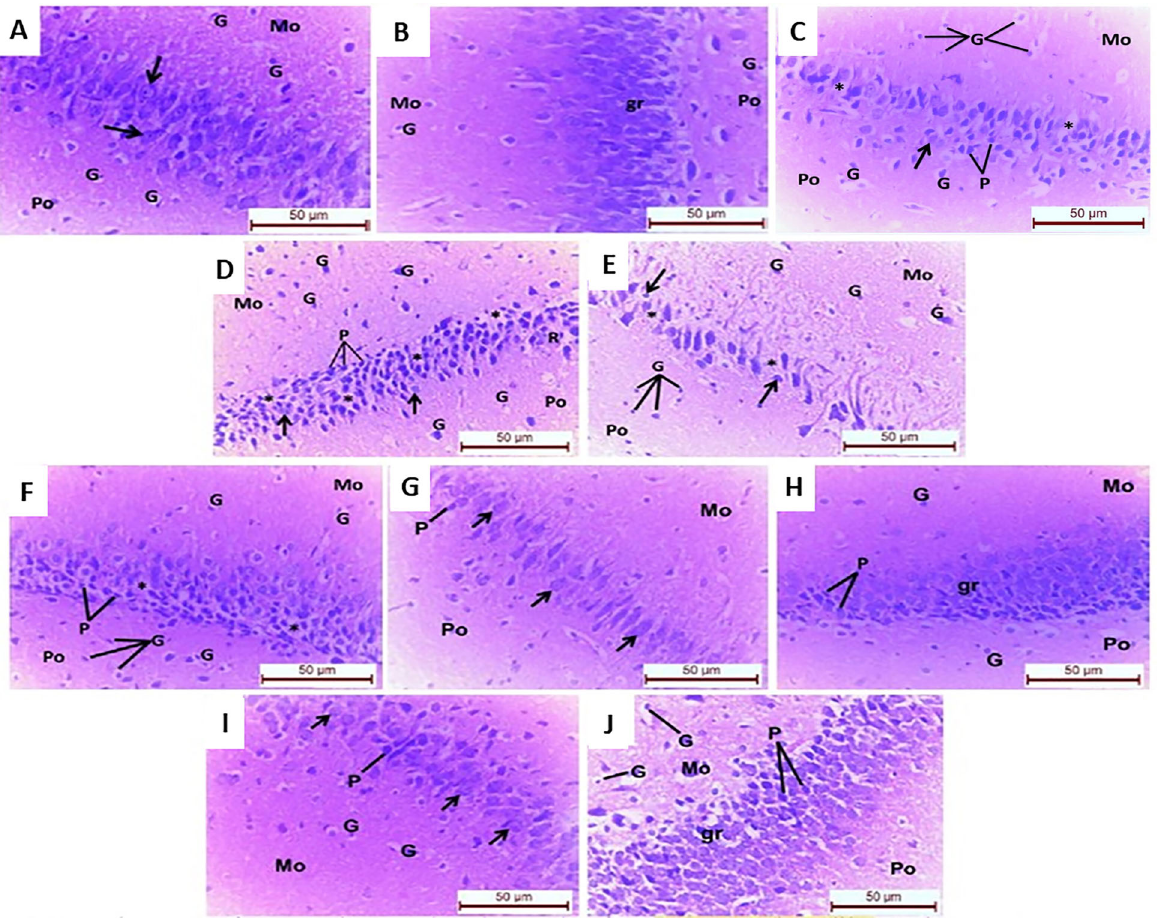
Figure 7. Photomicrographs of hematoxylin and eosin-stained sections from rat hippocampus (7 – 8 months age) of the study groups. Control and ouabain-treated groups revealing ( A ) normal CA3 zone showing layers of large pyramidal cells (arrows) and glial cells (G) in the molecular (Mo) and polymorphic (Po) layers, ( B ) normal granular cells (gr) in the dentate gyrus with scattered glial cells (G) appear in the molecular (Mo) and polymorphic (Po) layers. Immobilization-stress displaying ( C ) degenerated large pyramidal cells in CA3 zone; cytoplasmic vacuolation (*), pyknotic (P), or karyolitic (arrows) nuclei. Numerous glial cells (G) are also seen within the molecular (Mo) and polymorphic (Po) layers, ( D ) dentate gyrus exhibiting pyknotic (P) and karyolitic (arrows) nuclear alterations and vacuolated (*) or rare fi ed (R) cytoplasm of granular cells. Several glial cells (G) are also noted in the molecular (Mo) and polymorphic (Po) layers of the dentate gyrus. Disturbed dark/light cycle displaying ( E ) a milder degeneration of pyramidal cells in CA3 zone; pyknotic nuclei (arrows) and vacuolated cytoplasm (*). Multiple glial cells (G) are also seen within molecular (Mo) and polymorphic layers (Po), ( F ) the dentate gyrus exhibiting areas of cytoplasmic vacuolation (*) and hyperchromatic small nuclei (P) of granular cells. The glial cells (G) appear numerous in molecular (Mo) and polymorphic (Po) layers of the dentate gyrus. Immobilization-ouabain revealing ( G ) pyramidal cells with apparently normal architecture; vesicular nuclei (arrows) except for scattered pyknotic nucleus (P). Note the molecular (Mo) and polymorphic (Po) layers with CA3 zone, ( H ) mostly normal granular cells (gr) apart from few pyknotic nuclei (P). The molecular layer (Mo) and polymorphic layer (Po) of dentate gyrus demonstrating scattered glial cells (G). Prolonged darkness-ouabain showing ( I ) apparently normal pyramidal cells with vesicular nuclei (arrows) except for scattered darkly stained nuclei (P), ( J ) preserved granular cells (gr), molecular layer (Mo) and polymorphic layer (Po) of dentate gyrus, except for few hyperchromatic nuclei (P) ( (cid:1) 400, scale bar: 50 m m; (49.65 ± 0.02) and the granular layer of the DG of the hippocampus (43.63 ± 2.9) in relation to that of control rats (I) (79.34 ± 0.35; and 71.53 ± 1.98; respectively) and OUA-treated group (II) (78.6 ± 0.44 and 71.53 ± 1.98, respectively).